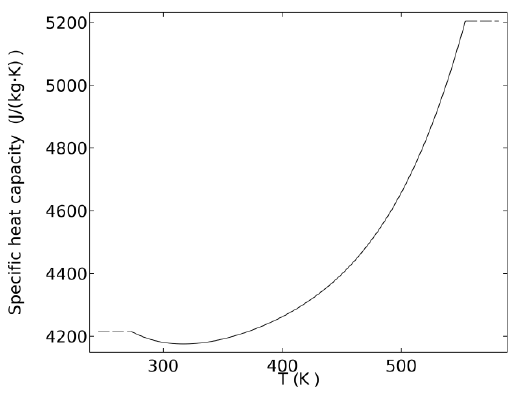
Figure 6. The specific heat capacity of the water changes with temperature.